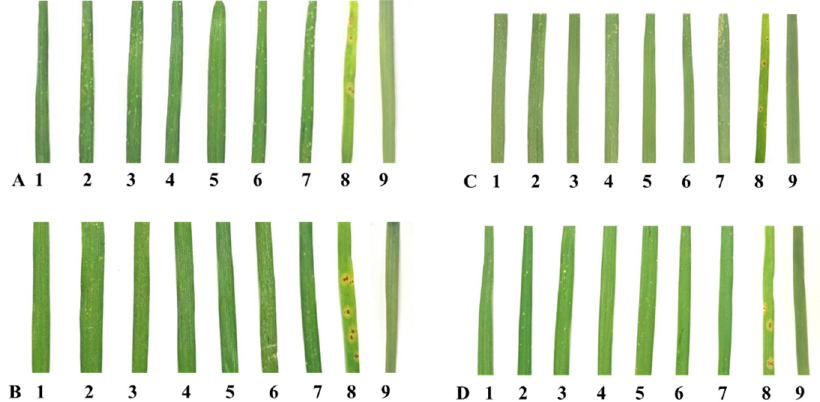
Figure 1. Infection type in seven dicoccum germplasm lines along with Mandsaur Local, a susceptible landrace, and Thatcher + Lr53 , a resistant control, against four pathotypes. ( A ) 12-4, ( B ) 77-1, ( C ) 107, ( D ) 108; A representative sample is taken from each group of pathotypes. Germplasm lines (Left to Right), 1. IC138898; 2. IC47022; 3. IC535116; 4. IC535133; 5. IC535139; 6. IC 551396; 7. IC534144; 8. Mandsaur Local; 9. Thatcher + Lr53 .